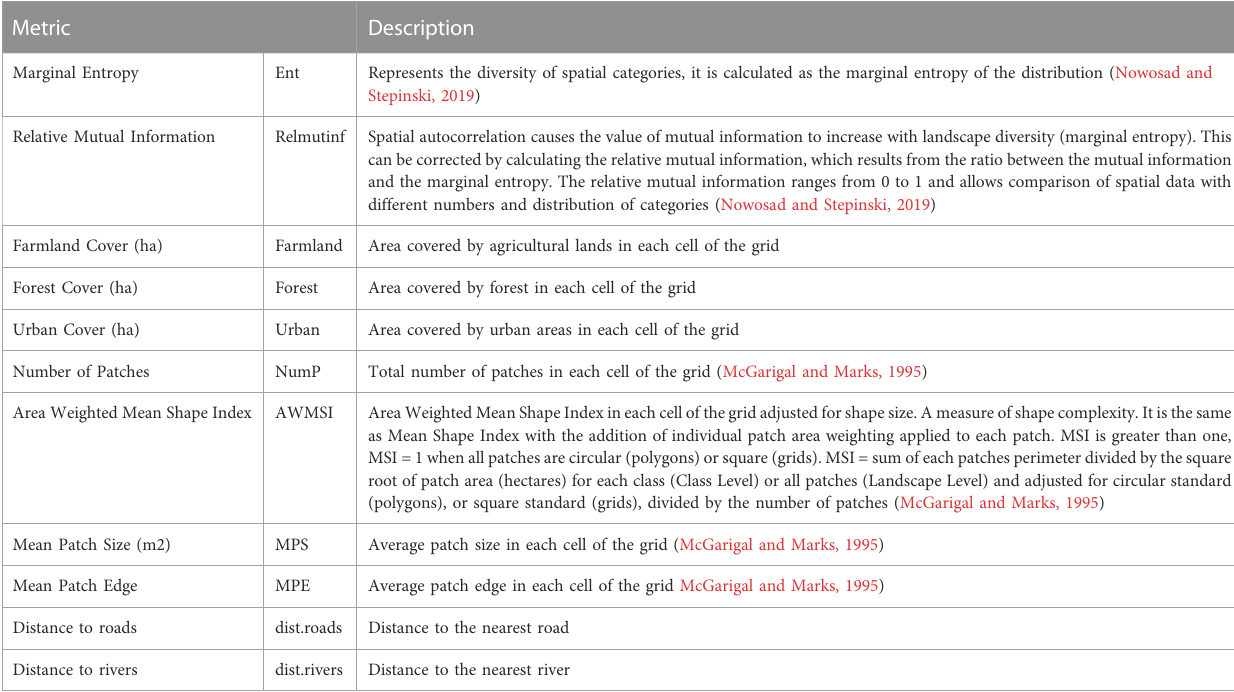
TABLE 1 Landscape metrics used to describe landscape structure surrounding recording sites in the Central Conservation Area of Costa Rica, 2019 – 2020.